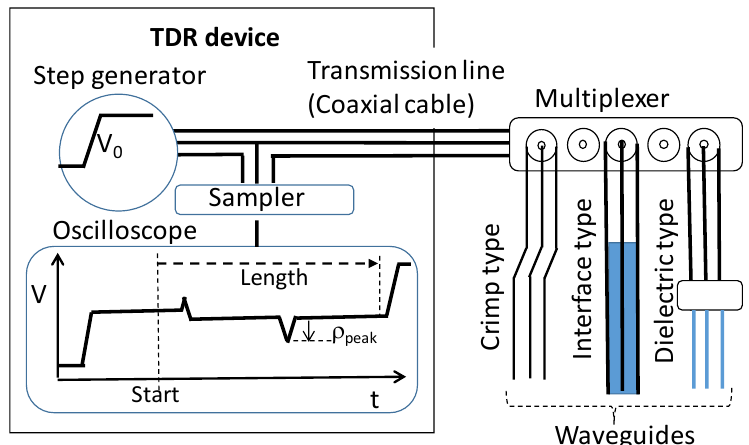
Figure 1. Time-domain reflectometry (TDR) schematic and related sensing waveguides.